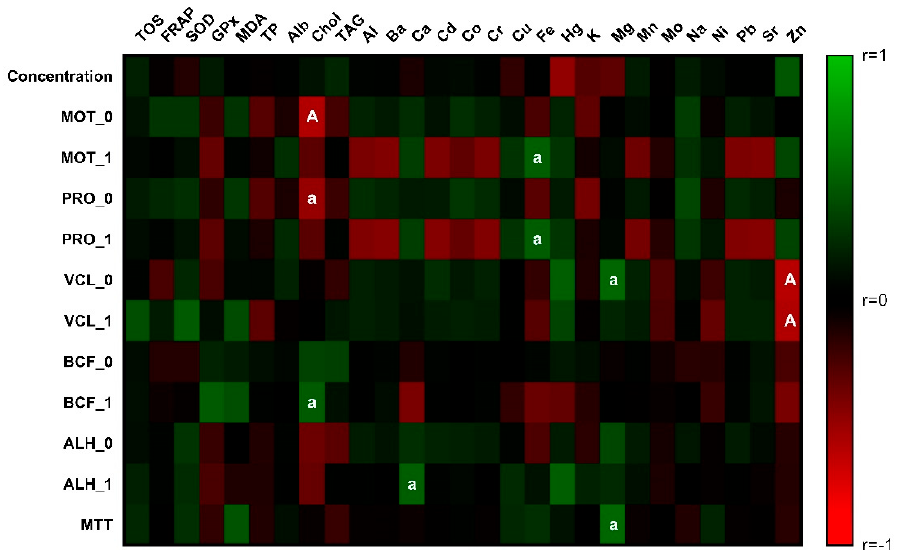
Figure 2. Correlations: spermatozoa parameters vs. markers of oxidative stress, biochemical parameters, and chemical elements. The level of significance: a ( p < 0.05); A ( p < 0.01).